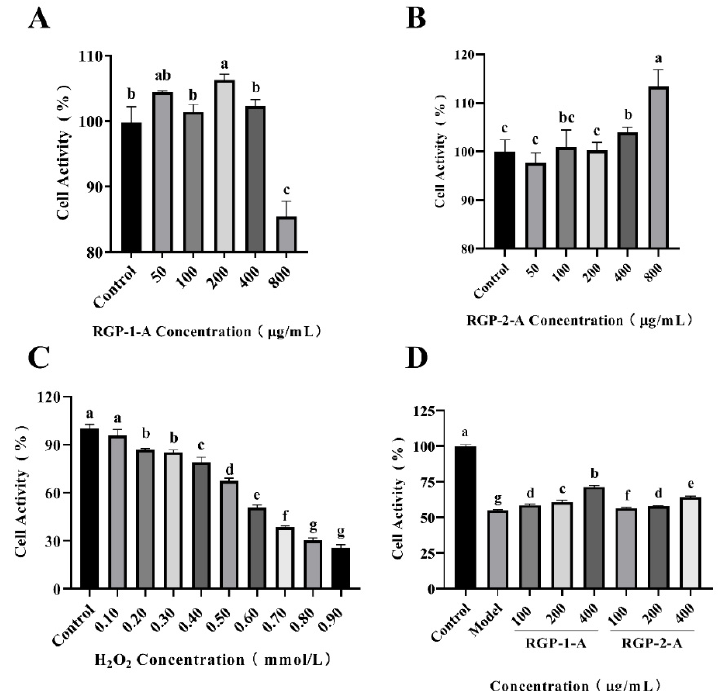
Figure 7. Effects of RGP − 1 − A ( A ) and RGP − 2 − A ( B ) on IPEC-1 cell proliferation (versus the untreated control). Cellular oxidative damage model established via the treatment of IPEC-1 cells with different concentrations of H 2 O 2 ( C ). Effects of RGP − 1 − A and RGP − 2 − A on IPEC-1 cell proliferation under oxidative stress ( D ). RGP − 1 − A: Rehmannia glutinosa polysaccharides decolorized by the AB-8 macroporous resin; RGP − 2 − A: Rehmannia glutinosa polysaccharides decolorized by H 2 O 2 . Different lowercase letters on the bar graph indicate significant differences ( p < 0.05).